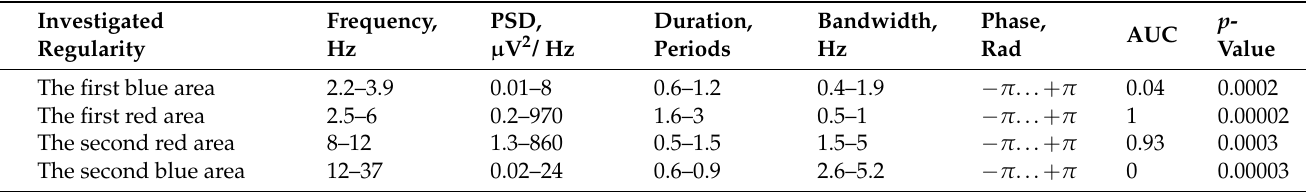
Table 2. Characteristics of cross-wave trains that distinguish PD and ET patients with right arm hyperkinetic